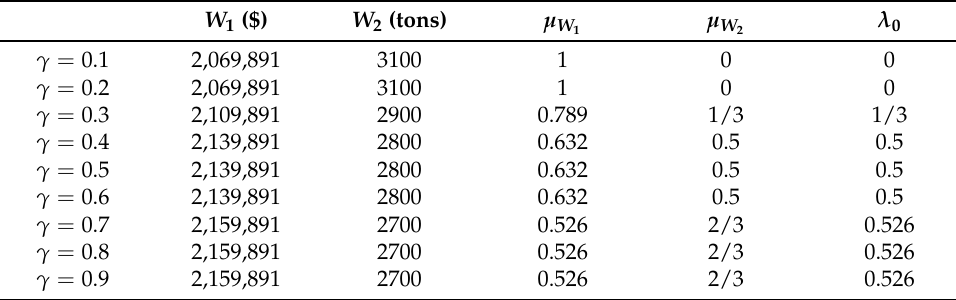
Table 2. Sensitivity analysis on the coefficient of compensation ( γ